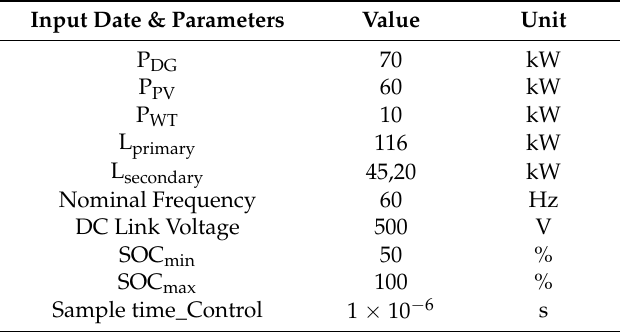
Table 1. Designed microgrid system configuration.